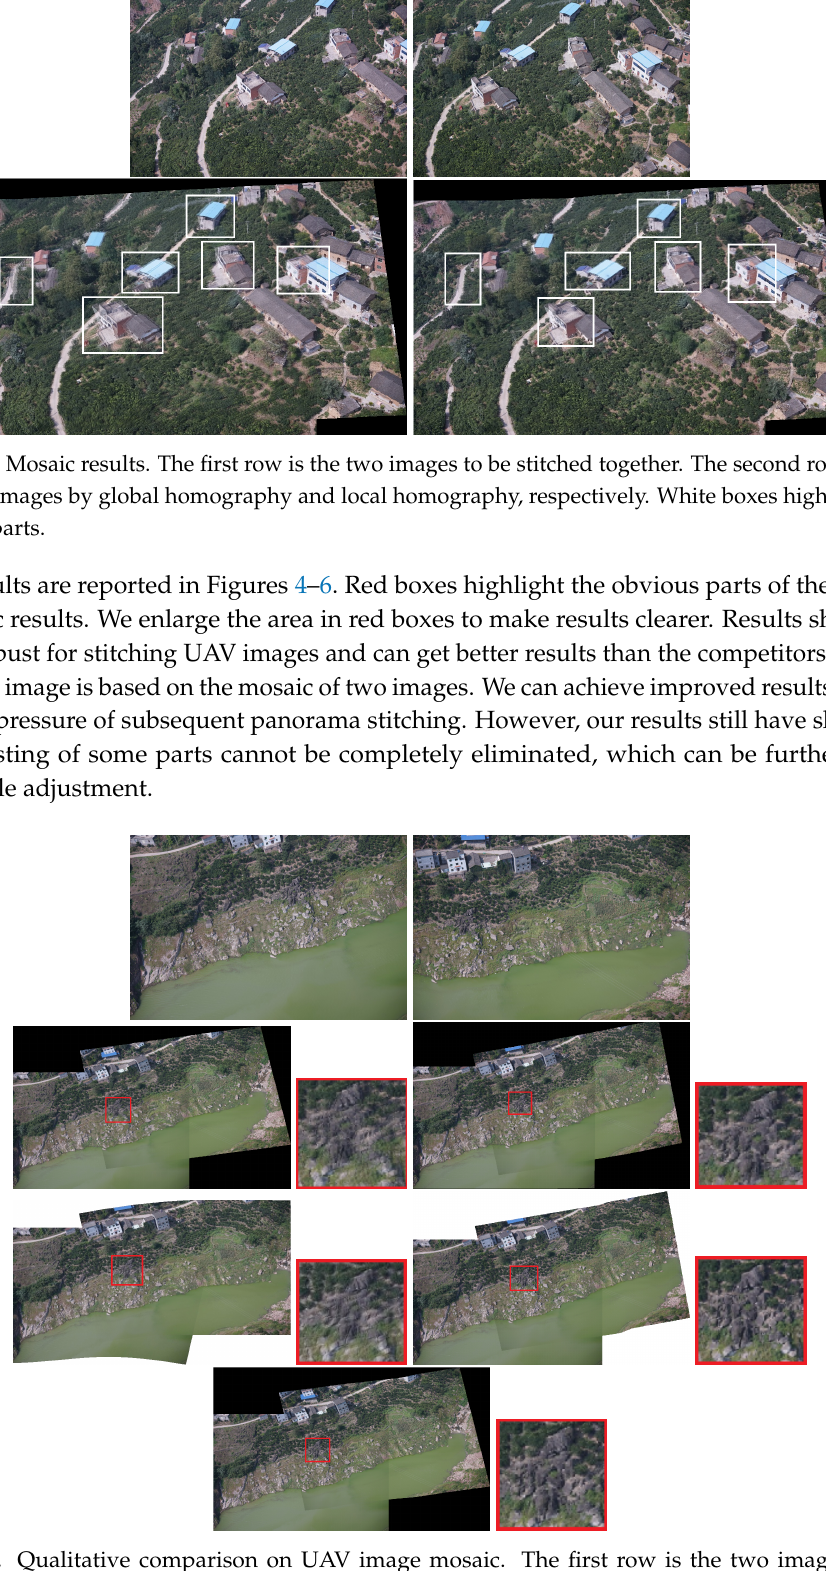
Figure 4. Qualitative comparison on UAV image mosaic. The first row is the two images to be stitched. The second and third rows are the stitching results of Autostitch [4], AANAP [41], SPHP [40], and PT [54]. Our result is shown in the last row. Red boxes highlight the ghostly